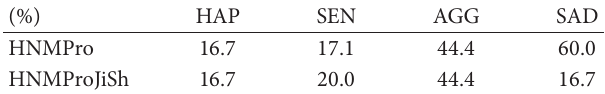
Table 6: 𝐹1 measure improvement percent (%) using “HNM- ProVoQ” compared with “HNMPro” and “HNMProJiSh” transfor- mation configurations. (%) HAP SEN AGG SAD HNMPro 16.7 HNMProJiSh 16.7